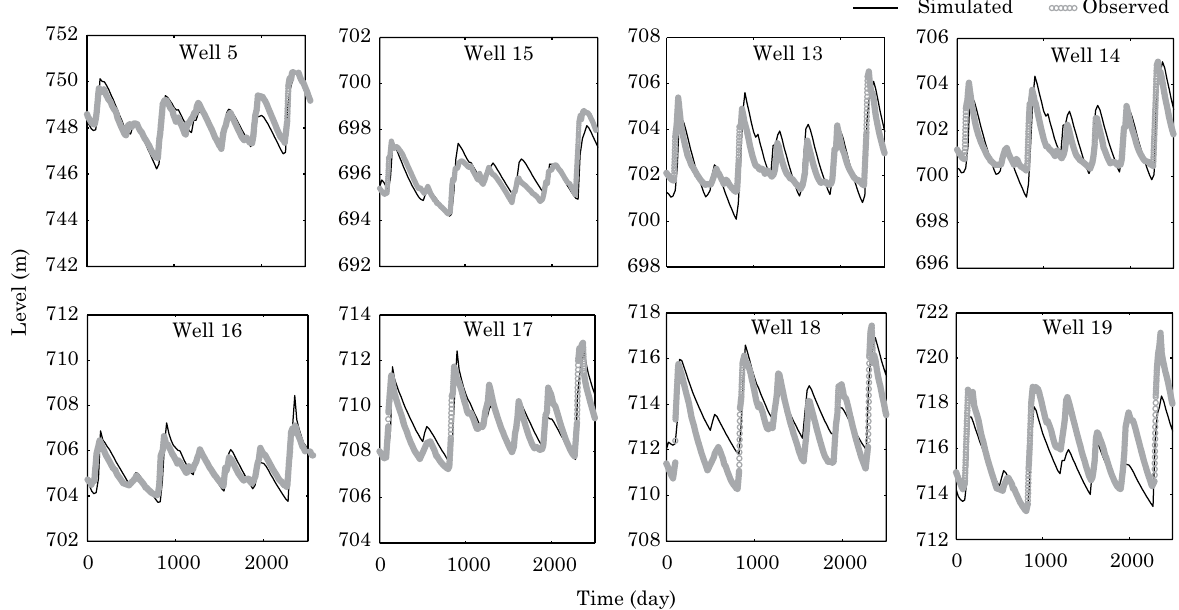
figure 7. results from model calibration. measured levels in red and sPa-simulated levels in